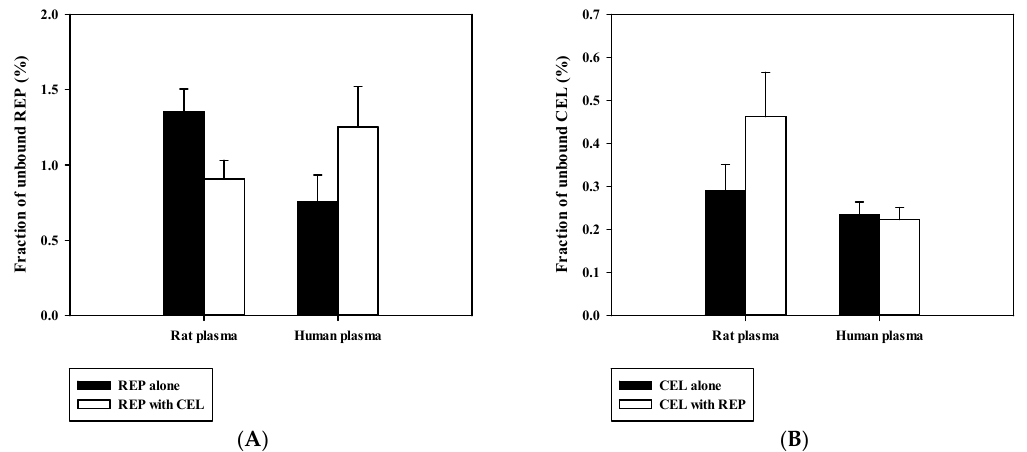
Figure 4. Dose-response curves for the inhibitory effect of REP on metabolic reactions of CEL in RLM ( A ) and HLM ( B ). The circles and vertical bars represent the means and standard deviations, respectively ( n = 4).